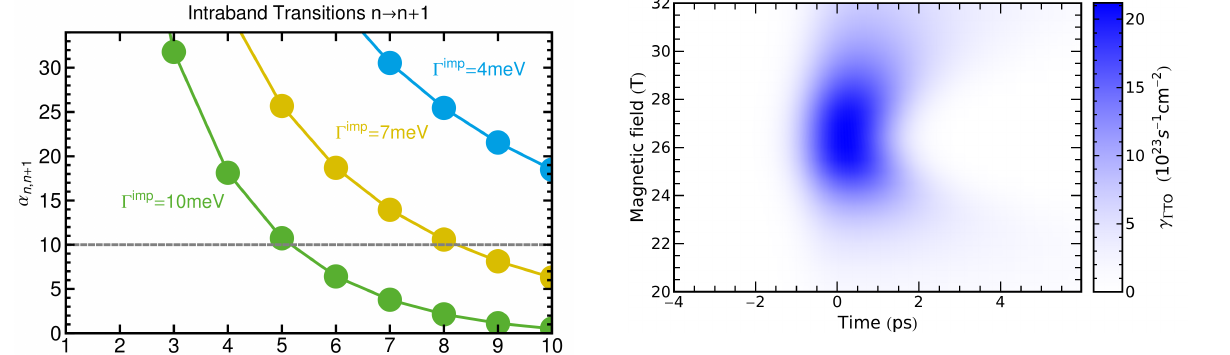
Figure 14: Carrier–optical–phonon relaxation rate. Surface plot showing the carrier–phonon scattering rate involving Γ TO phonons inducing transitions LL +1 → LL 0 and LL 0 → LL −1 as a function of time and magnetic